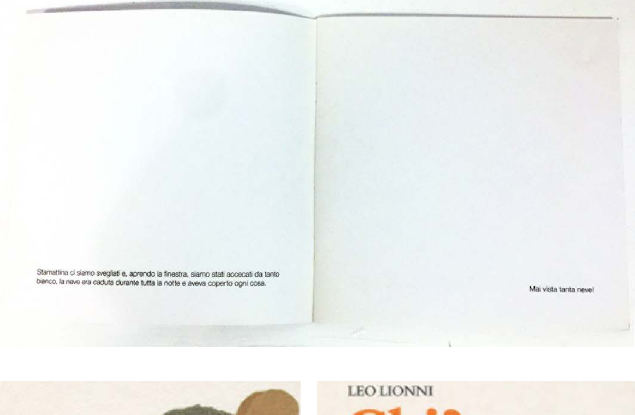
Fig. 19 Bruno Munari, Cappuccetto Bianco , 1999